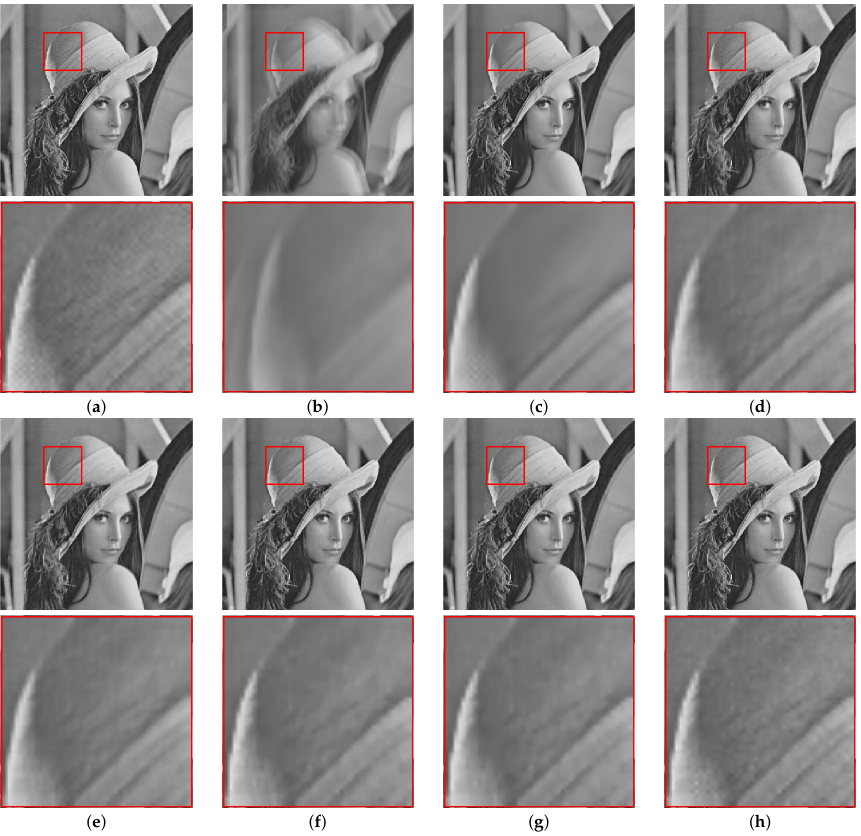
Figure 1. The Lena image restored by all algorithms. ( a ) Lena, ( b ) degraded, ( c ) IDBP, ( d ) D-ADMM(a), ( e ) D-ADMM(i), ( f ) APE-TV, ( g ) APE-TGV, and ( h )